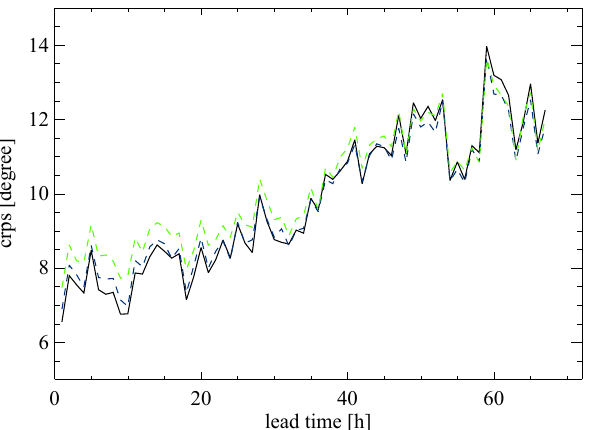
Figure 10. Circular continuous rank probability score for the observed wind directions for lead times from 0–72 h. Black solid line: standard deviation 10 ◦ ; blue dashed line: standard deviation 15 ◦ and green dashed line: standard deviation 20 ◦ .